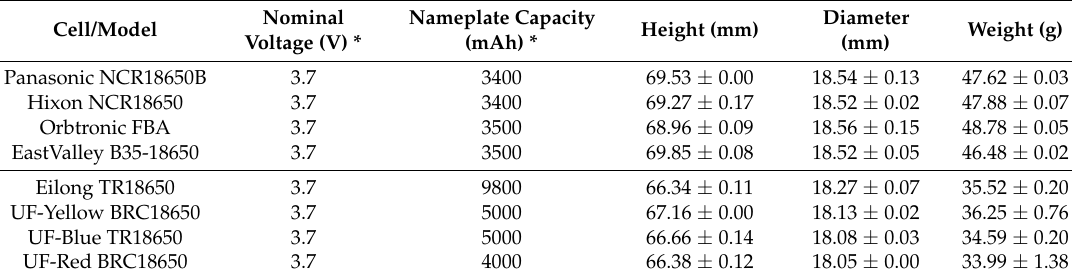
Table 1. Protected 18650 cell